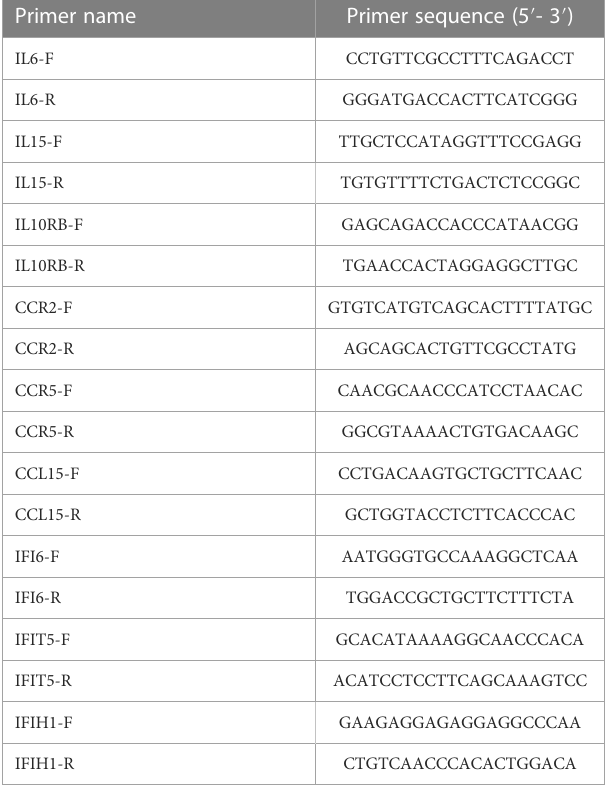
TABLE 2 qPCR Primers to verify the level of gene